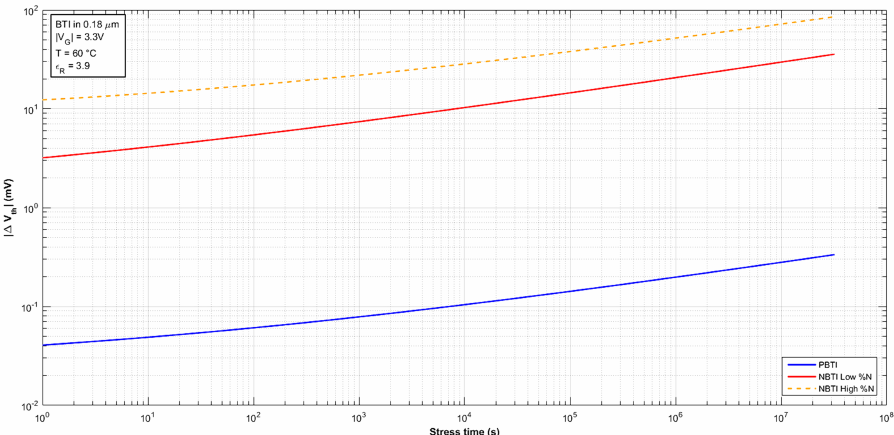
Figure 14. Hand-adjusted results for physics-based BTI models to match the measured results in [7] for 0.18- µ m MOSFET technology under one year of stress.